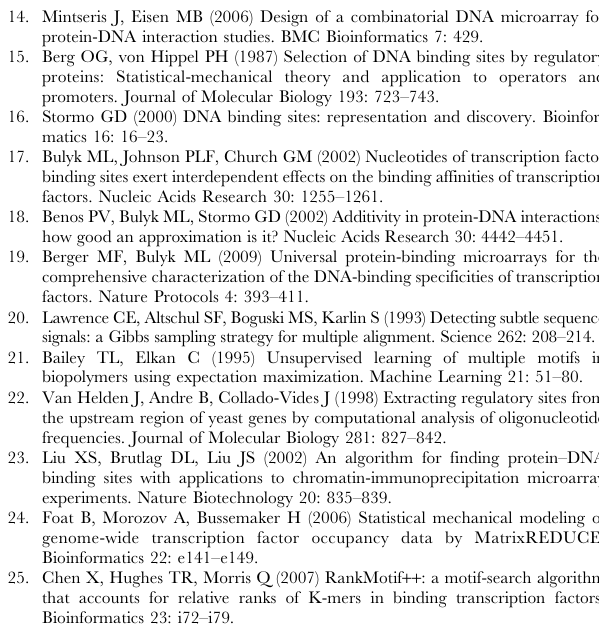
Figure S1 Examples of PBM samples with spatial artifacts. Red pixels indicate missing intensity values. Figure S2 Effect of the regularized K-mer count on prediction accuracy. Figure S3 Probe noise modeling. The figure shows a scatter plot of the relationship between average probe intensities and sample standard deviations, across three Zscan10 PBM replicate samples. Also shown is the least squares linear fit to the data. Table S1 Prediction accuracies for all 86 sample pairs (HK R ME). Legend: This table contains the full prediction accuracy assessments for all 86 PBM sample pairs and 7 different